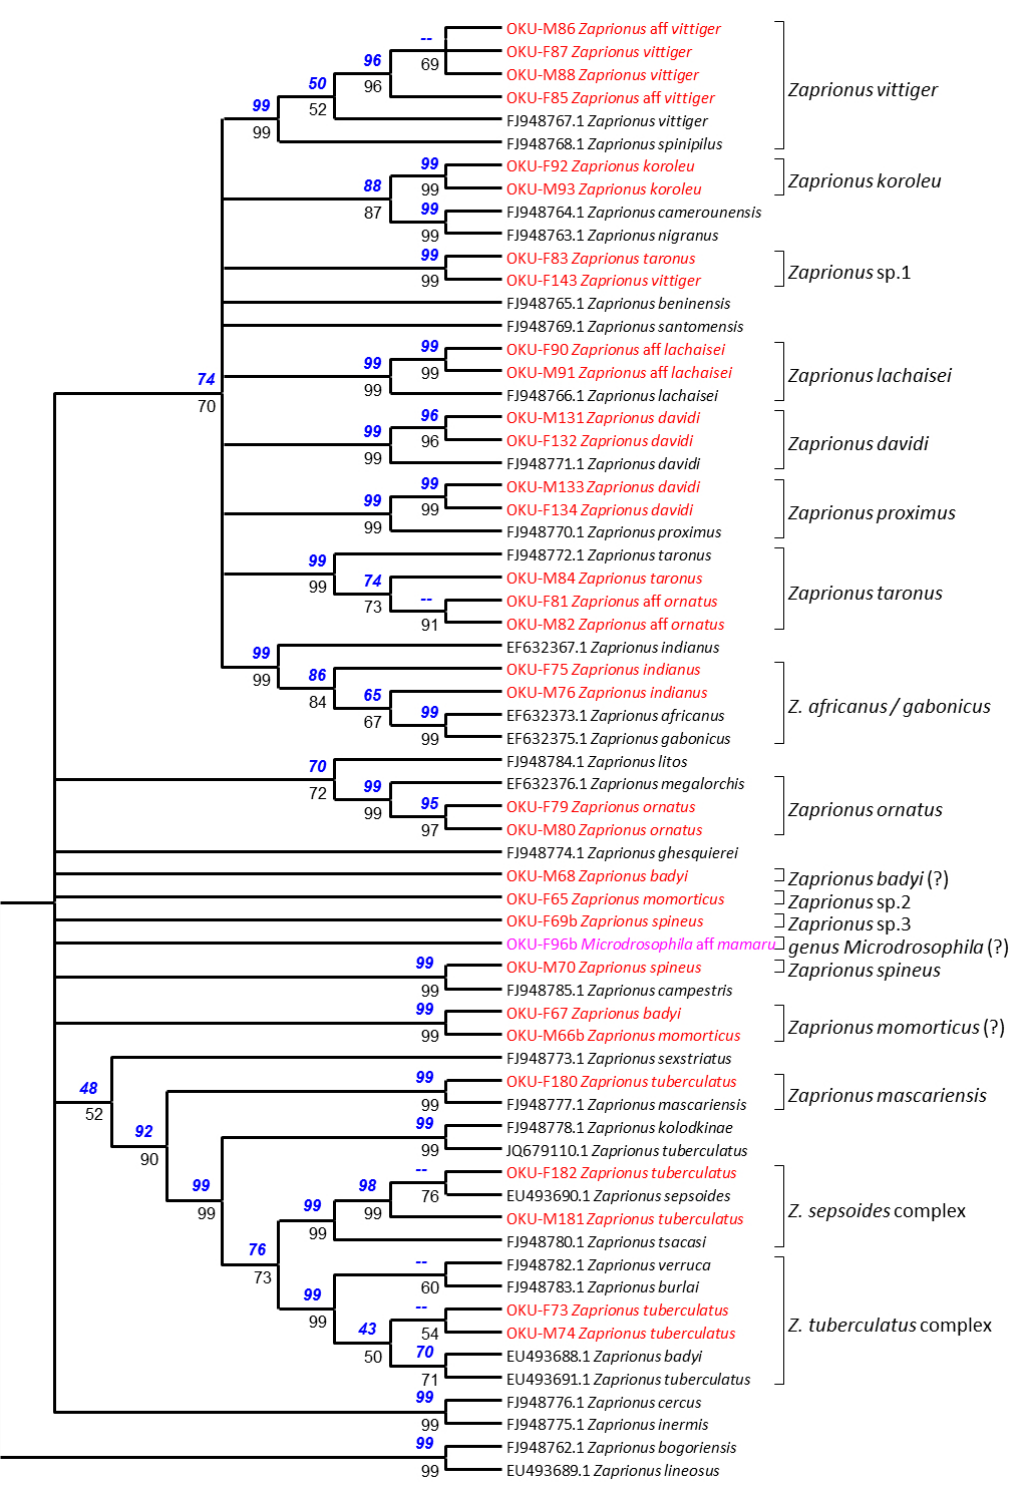
Fig. 3. Phylogenetic analysis of the genus Zaprionus and Microdrosophila aff. mamaru (Burla, 1954). This tree is the neighbor-joining tree. The maximum likelihood tree gives the same topology. Nodes with a bootstrap value lower than 50% were merged. Bootstrap values were calculated over 1000 repeats. Above nodes: bootstrap values for maximum likelihood using a GTR + G + I model. Below nodes: bootstrap values for neighbor-joining using the Kimura-2p